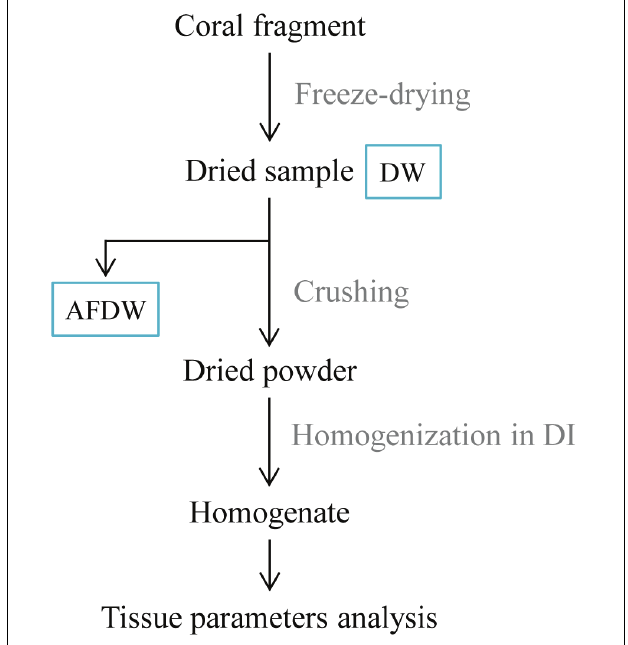
FIGURE 4 | Optimized workflow for processing soft coral tissue samples. DW, dry weight; AFDW, ash-free dry weight; DI, Milli-Q